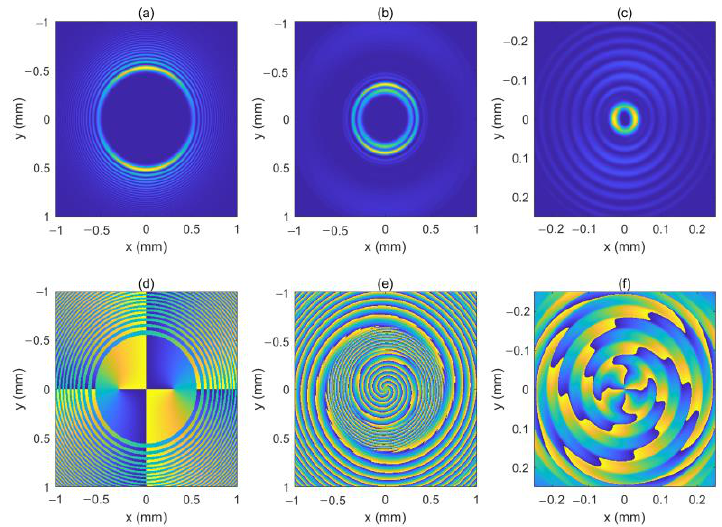
Figure 11. The intensity pattern and phase distribution of the RHCP component at different distances. ( b , c ) show the intensity pattern for z = 100 mm and z = 180 mm, respectively. ( e , f ) show the phase distribution for z = 100 mm and z = 180 mm, respectively. The intensity pattern and phase distribution of the initial beam are also shown in ( a ) and ( d ).